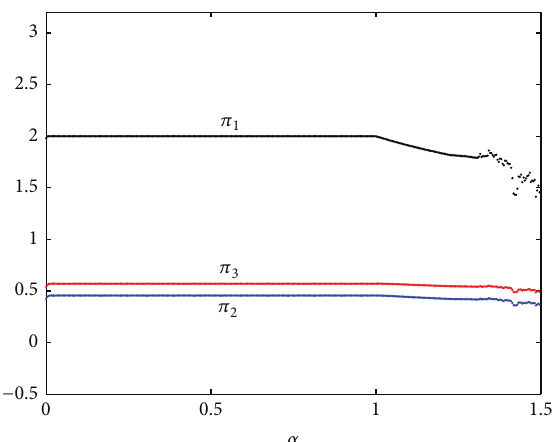
Figure 13: The long-run average profits of the players with 𝛼 for the controlled system